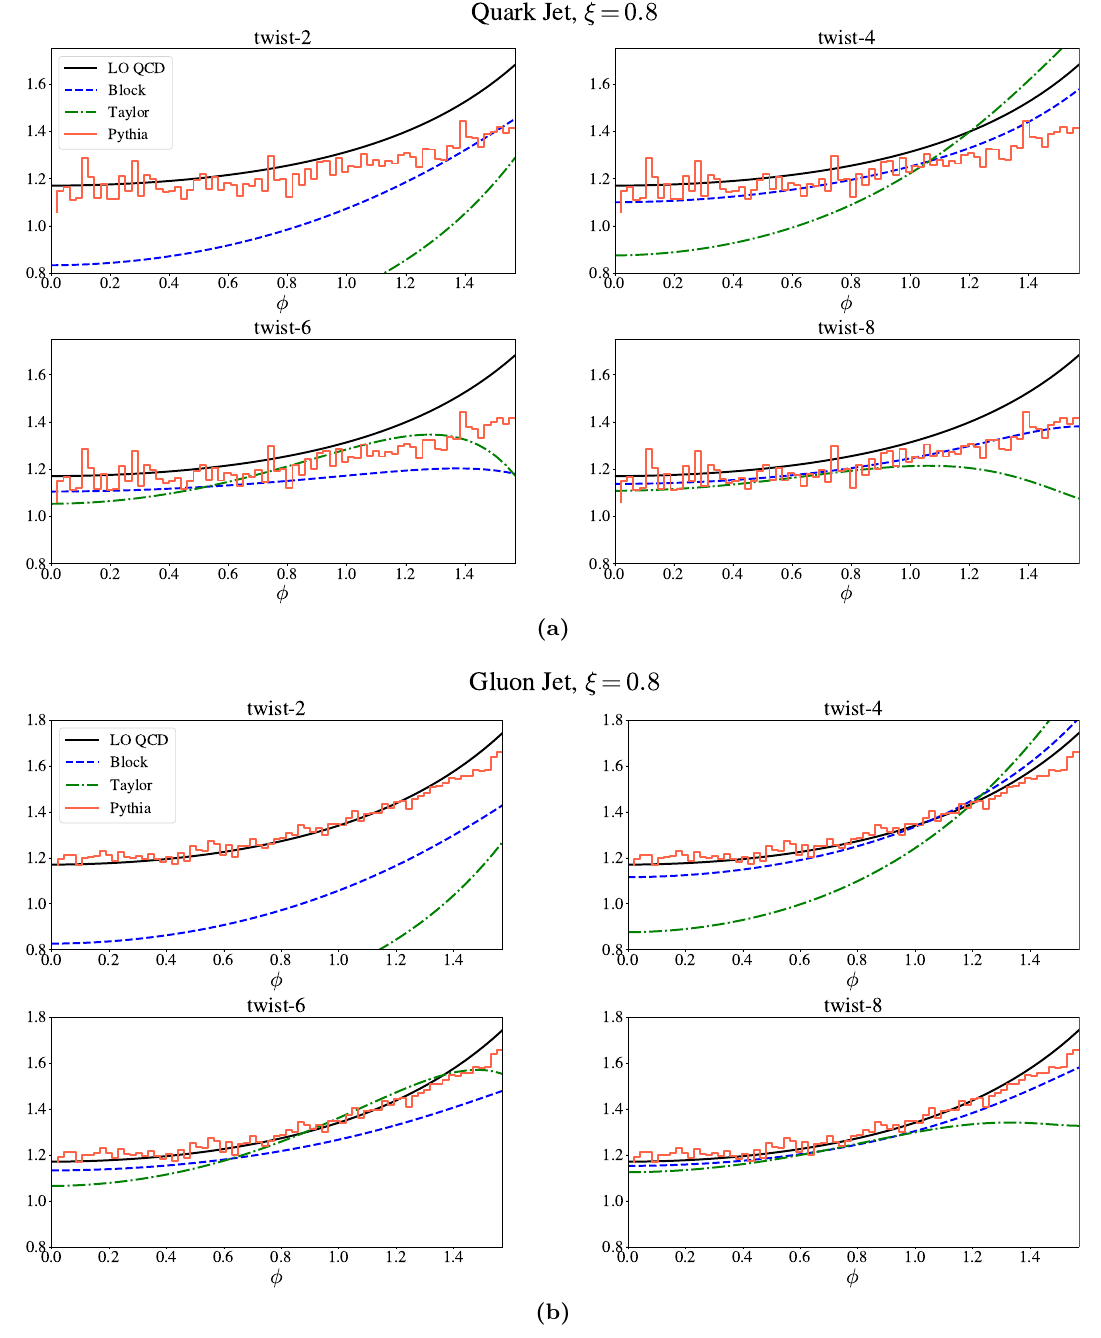
Figure 15. A slice of the leading order three-point correlator at ξ = 0 . 8 for quark jets in (a) and gluon jets in (b). We compare the full QCD result, the expansion in celestial blocks, the naive Taylor expansion, and the result from Pythia. The expansion in celestial blocks converges